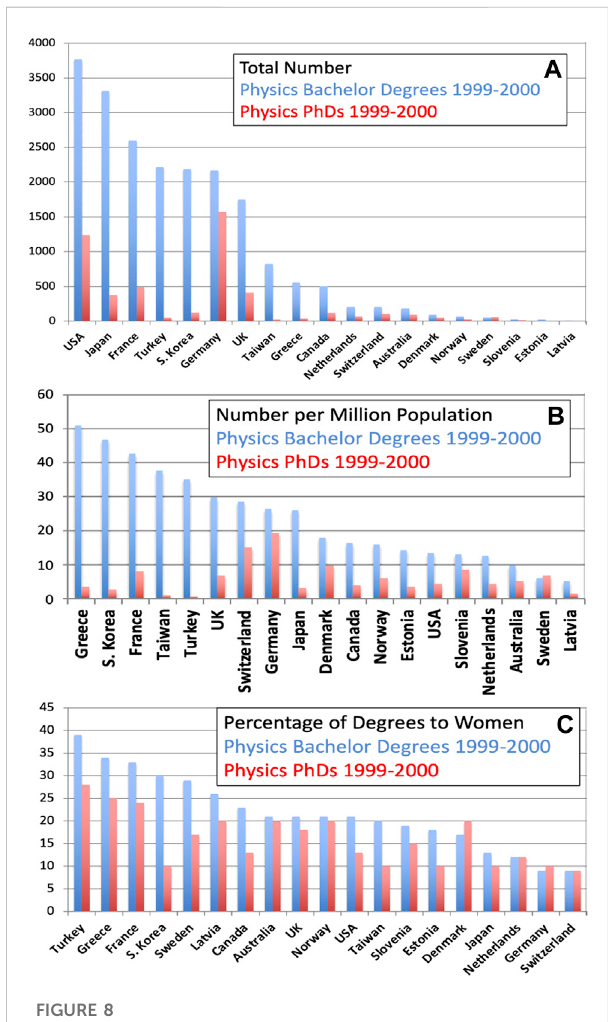
FIGURE 8 Physics degrees awarded(averagedover 2 years 1999 – 2000)for 19countries. (A) Totalnumber; (B) permillionpeopleineachcountry ’ s population; (C) percentage to women. Based on Ivie and Guo (2006) which says “ To beincluded, countries had to provide appropriate data from reliable statistical agencies ”